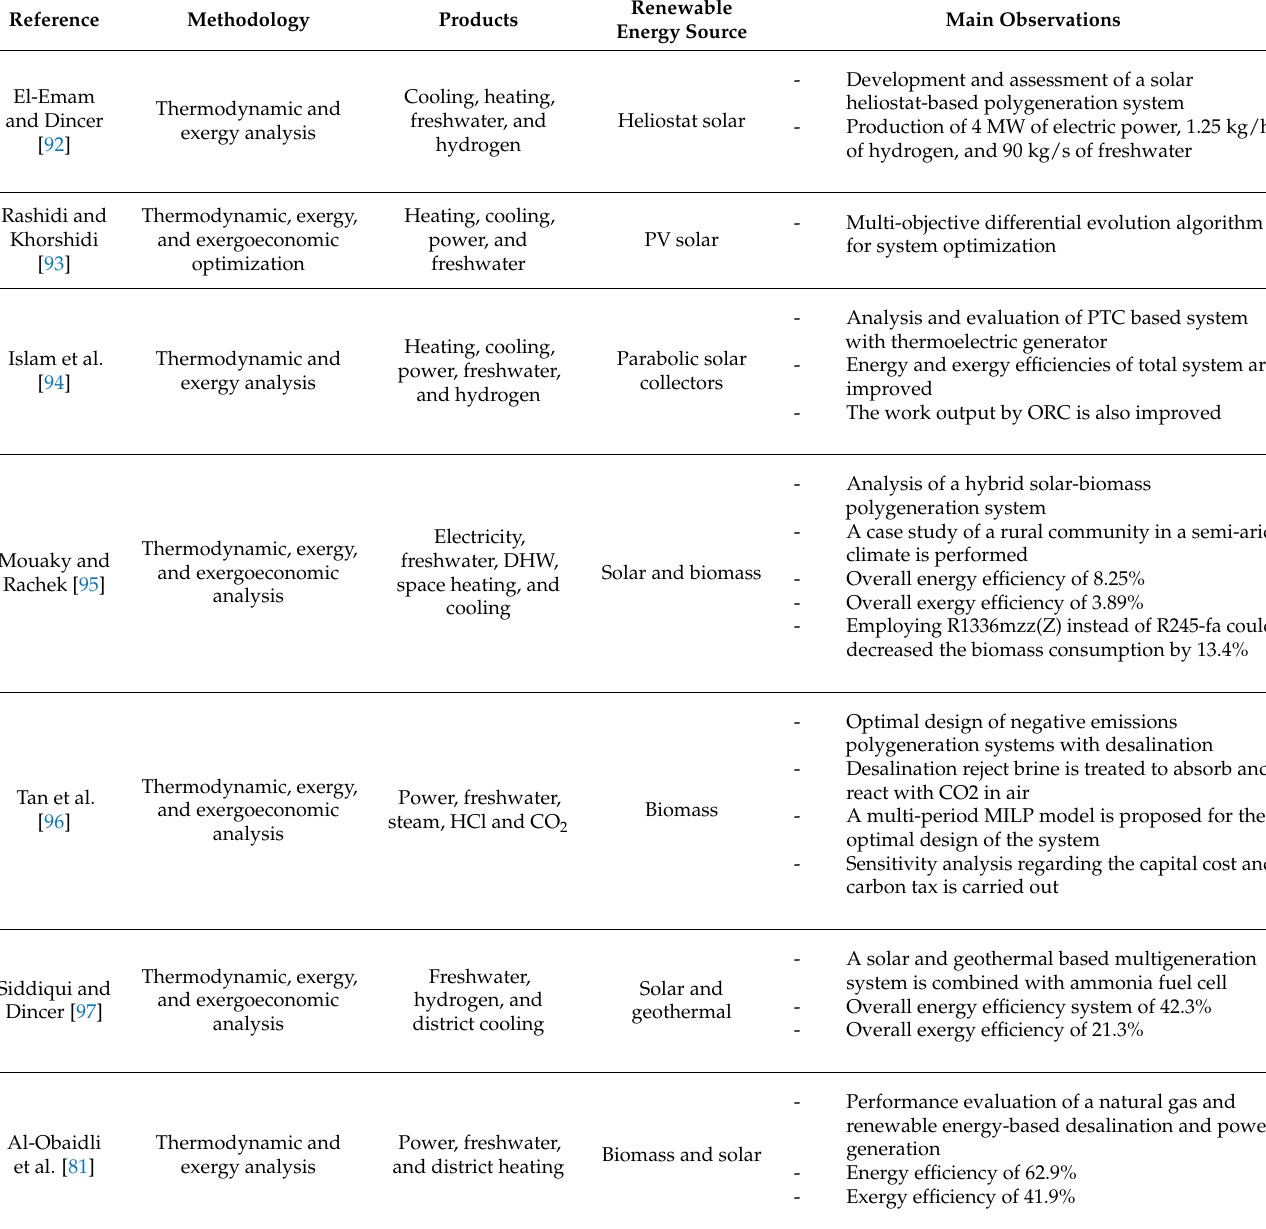
Table 4. Summary of topical research on integrated renewable energy-driven polygeneration and RO desalination systems.